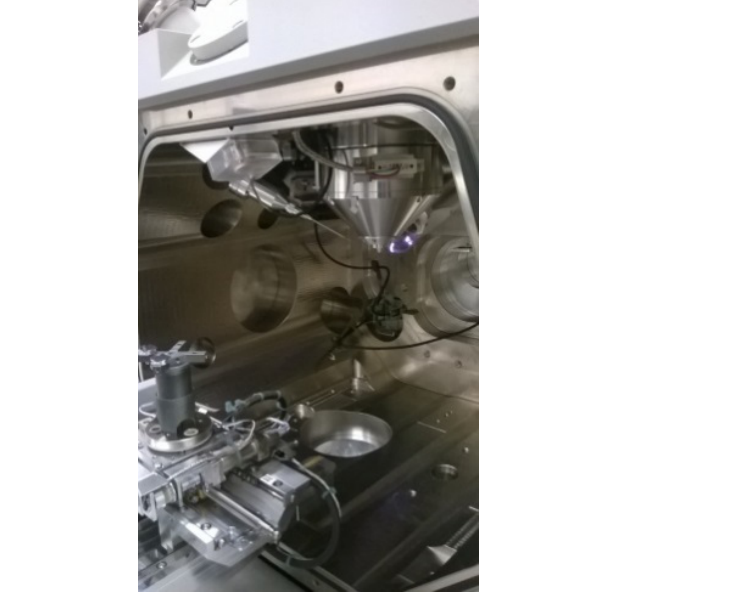
Figure 3: Chamber-view inside the SEM with pole shoe, gas injection needle and sample table. IR-CCD camera permits to track the sample